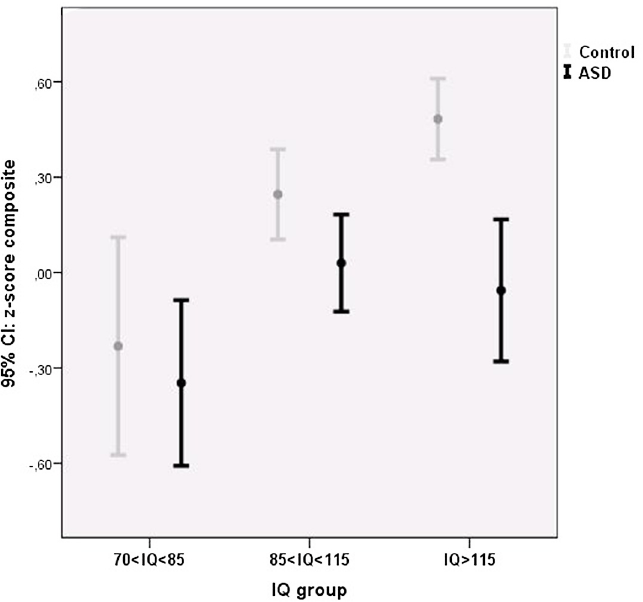
Fig 1. The effect of ASD and IQ on the cognitive composite score. Standardized z-score composed of the speed & accuracy measures of all task variables. Higher z-scores are indicative of better performance (faster performance and/or less